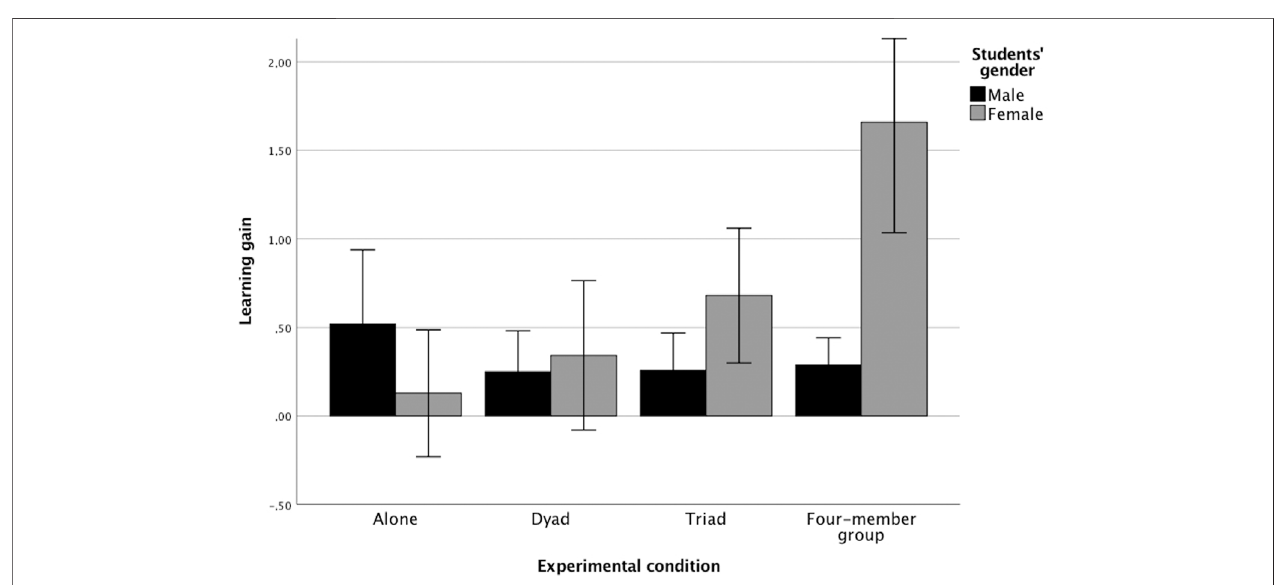
FIGURE 3 | Learning gain according to experimental condition and student